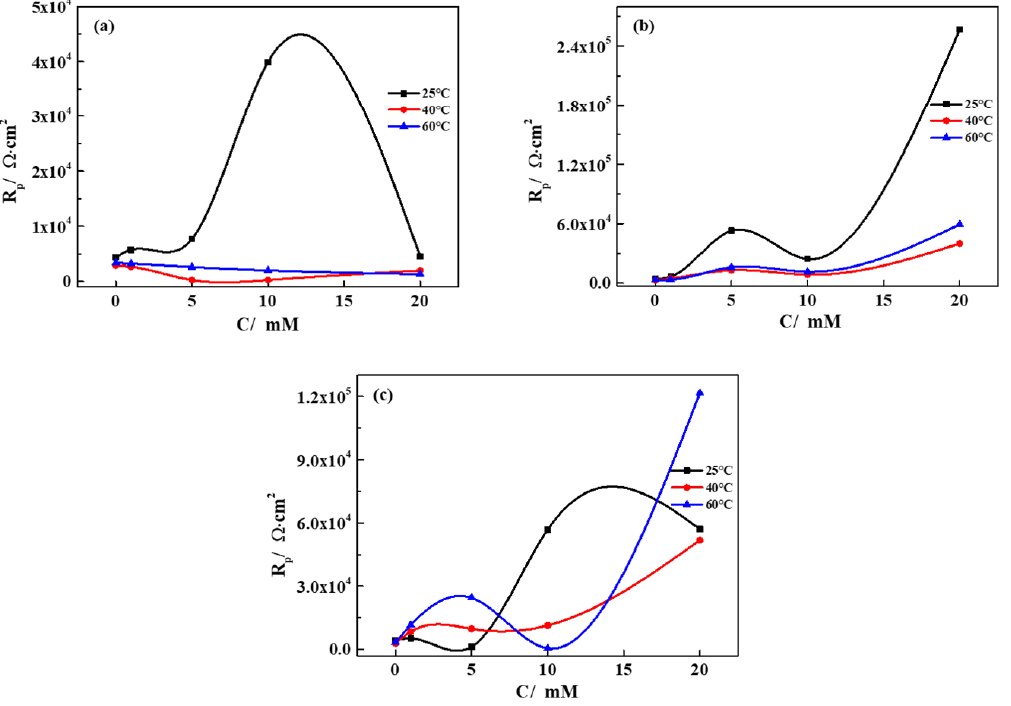
Figure 5. The variation in the polarization resistance of iron with concentration/temperature in different simulated groundwaters. ( a ) SG + CaCl 2 ; ( b ) SG + Na 2 CO 3 ; ( c ) SG + Na 2 SiO 3 .